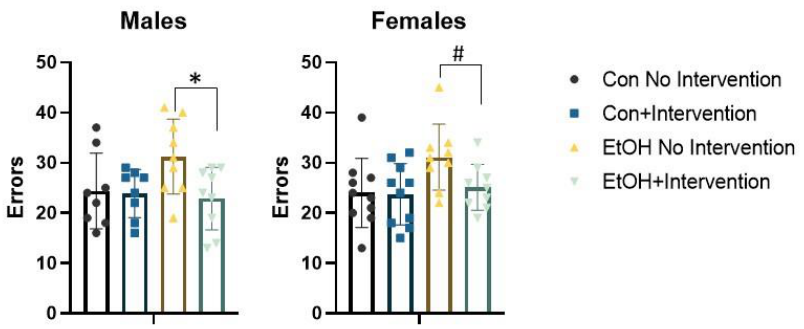
Figure 3. The total number of errors made during the attentional set shifting and reversal learning task in adult rats. Prenatal ethanol increased the number errors in males, p = 0.049, and females, p = 0.039. The intervention reduced errors in EtOH rats in males, * p = 0.02, and females # p = 0.03. Con=Control, EtOH=Ethanol.